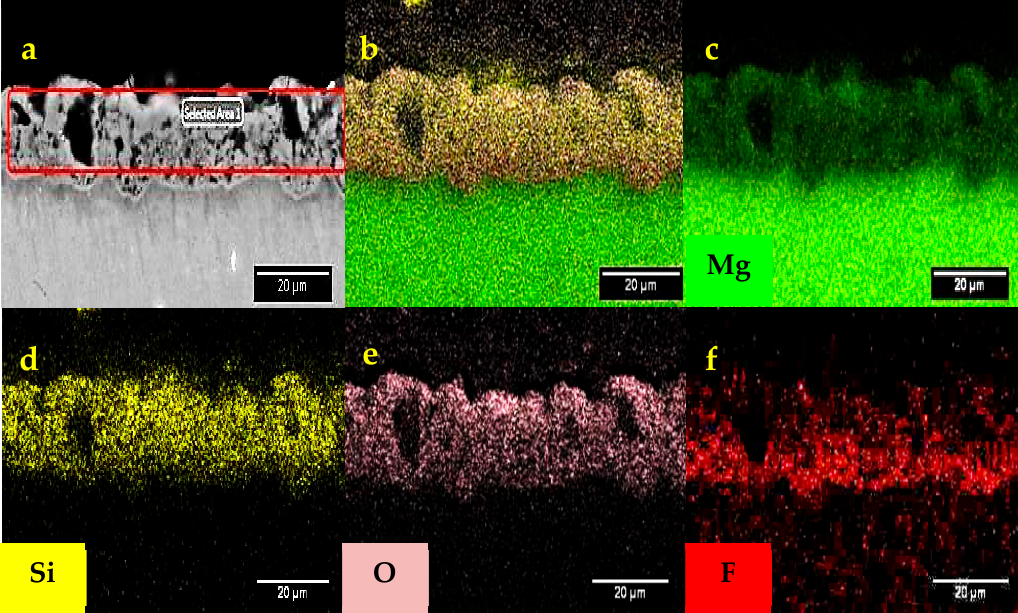
Figure 8. ( a ) Cross-section and elemental maps of B2 produced coating; ( b ) overall colors map, ( c ) map of magnesium, ( d ) map of silicon, ( e ) map of oxygen and ( f ) map of fluoride.